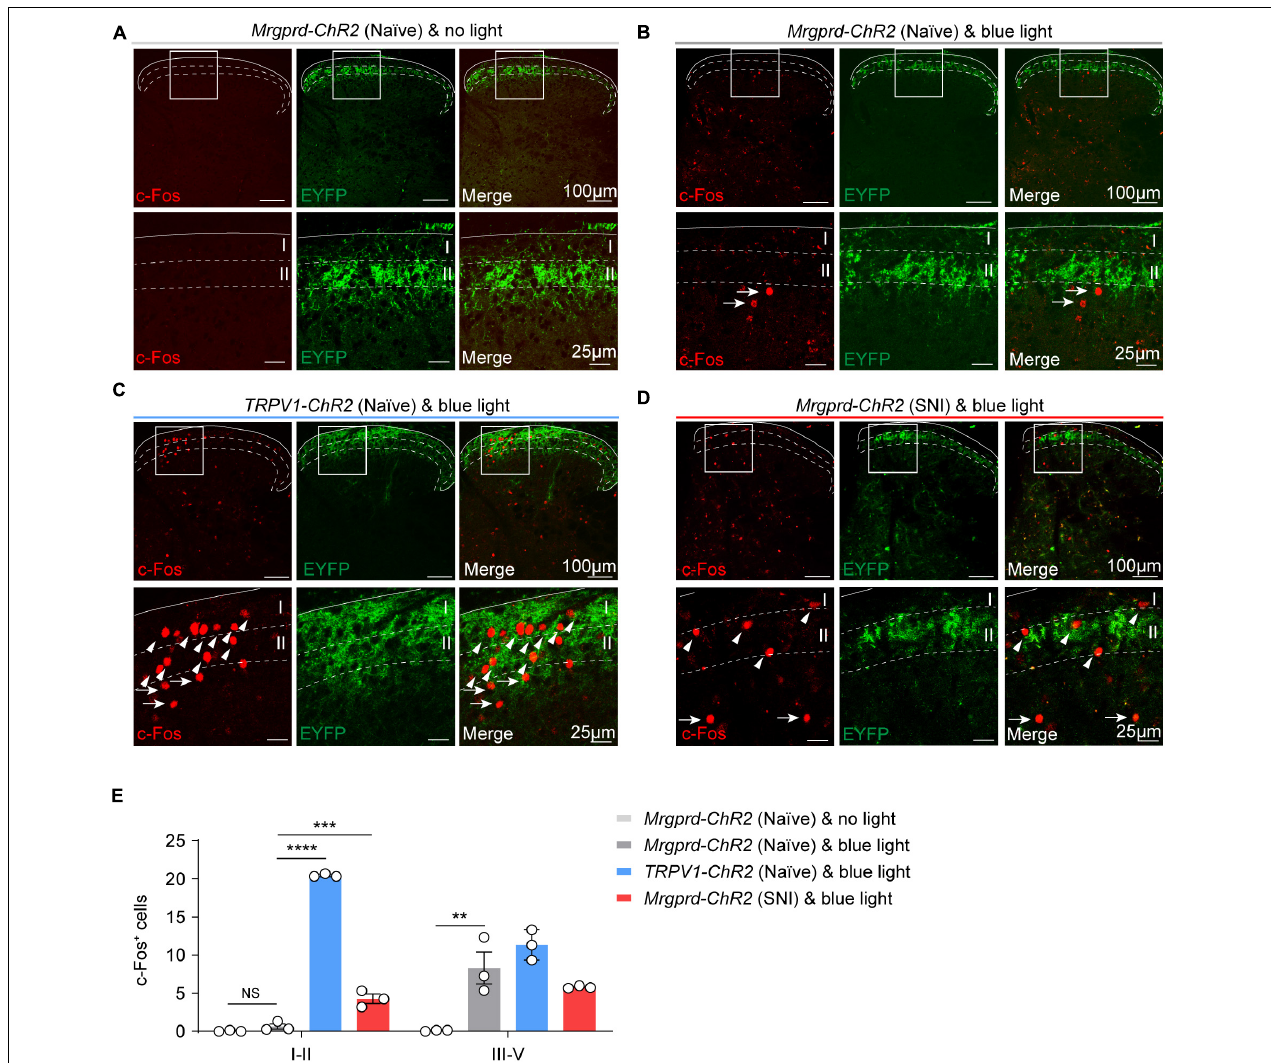
FIGURE 5 | Spatial distribution of c-Fos + neurons in the spinal cord following optogenetic activation of cutaneous Mrgprd + and TRPV1 + fibers. (A) Representative images of c-Fos (red) baseline expression without light stimulation in Mrgprd-ChR2 mice. (B–D) Representative images of c-Fos (red) expression within the spinal dorsal horn evoked by hindpaw blue light stimulation in naïve Mrgprd-ChR2 mice (A) , naïve TRPV1-ChR2 mice (B) and SNI Mrgprd-ChR2 mice (C) . The arrowhead and arrow indicate c-Fos + cells in lamina I–II and lamina III–V, respectively. Scale bar, 100 µ m (25 µ m for high magnification). (E) Statistical data of c-Fos + cells within the lumbar spinal cord without light or evoked by hindpaw blue light stimulation in naïve Mrgprd-ChR2 mice, naïve TRPV1-ChR2 mice and SNI Mrgprd-ChR2 mice ( n = 3 animals per group). Data are presented as mean ± SEM. “NS,” no significance, ** p < 0.001, *** p < 0.001, **** p < 0.0001. One-way repeated-measures ANOVA with holm-sidak test for (E)